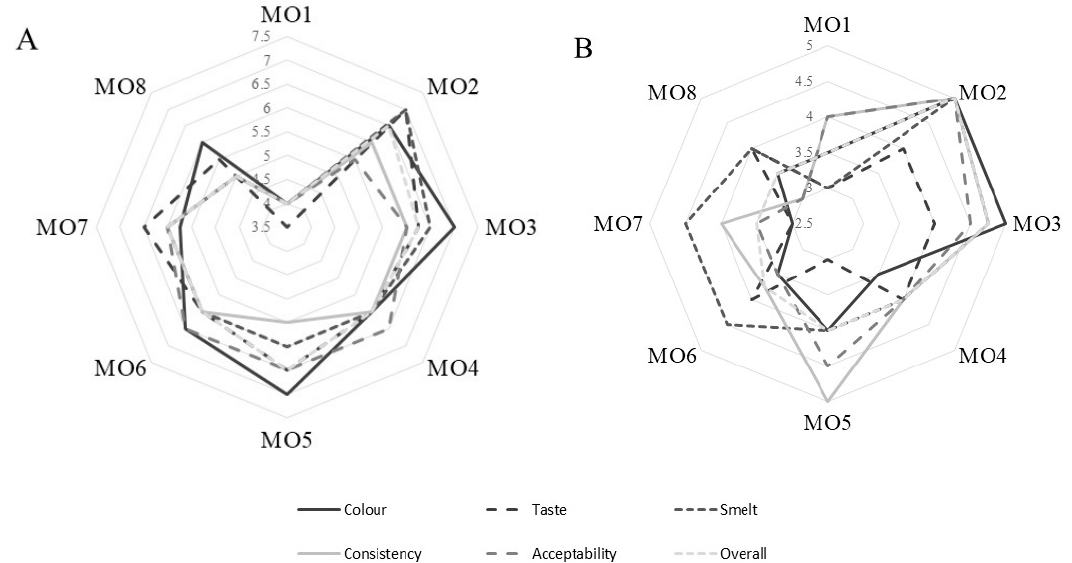
Figure 1. Consumer quality of powdered beverages: A—rehydration at 20 ◦ C; B—rehydration at 80 ◦